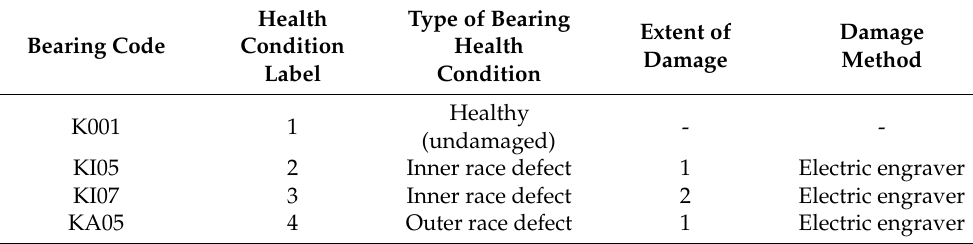
Table 1. Description of health classes for Paderborn dataset.